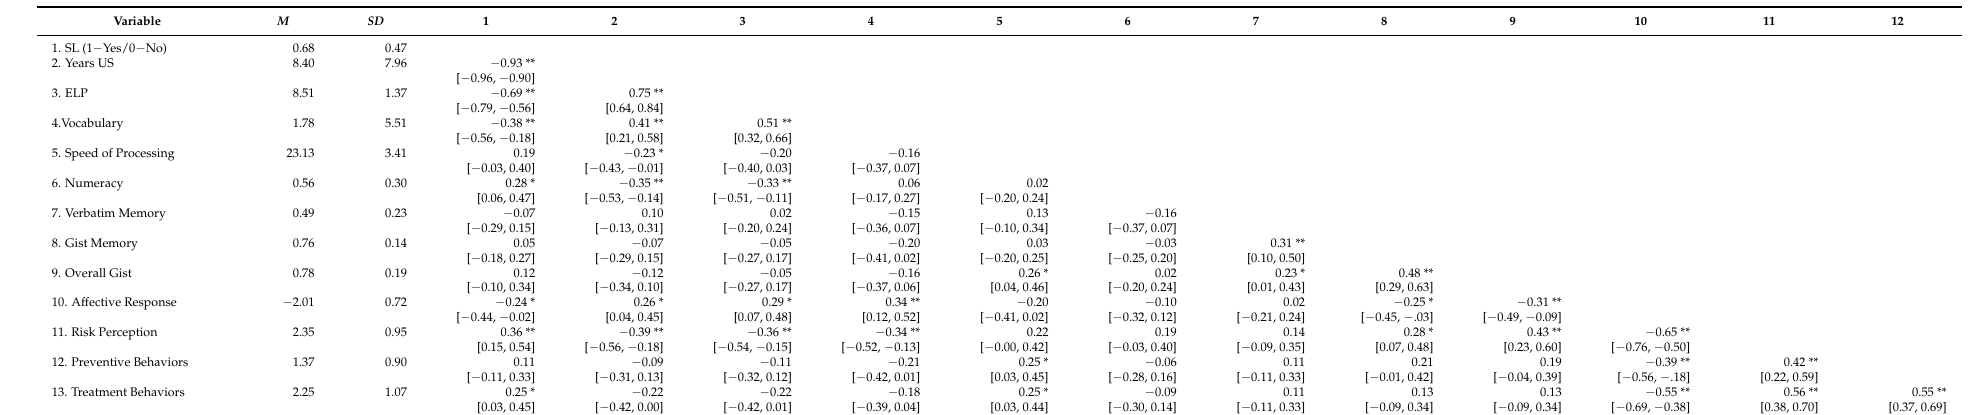
Table A1. Means, Standard Deviations, and Pearson’s Correlations with Confidence Intervals (n =